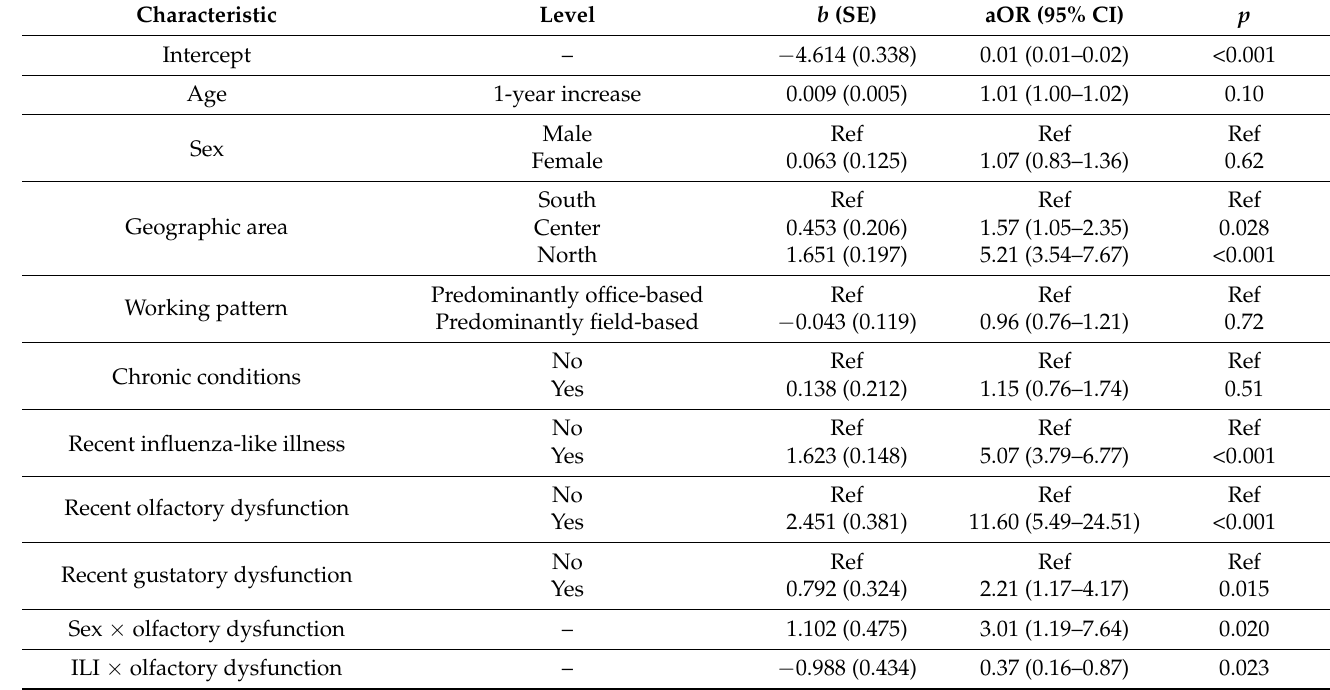
Table 3. Multivariable logistic regression model to predict the SARS-CoV-2 seropositivity status ( n = 510). Characteristic